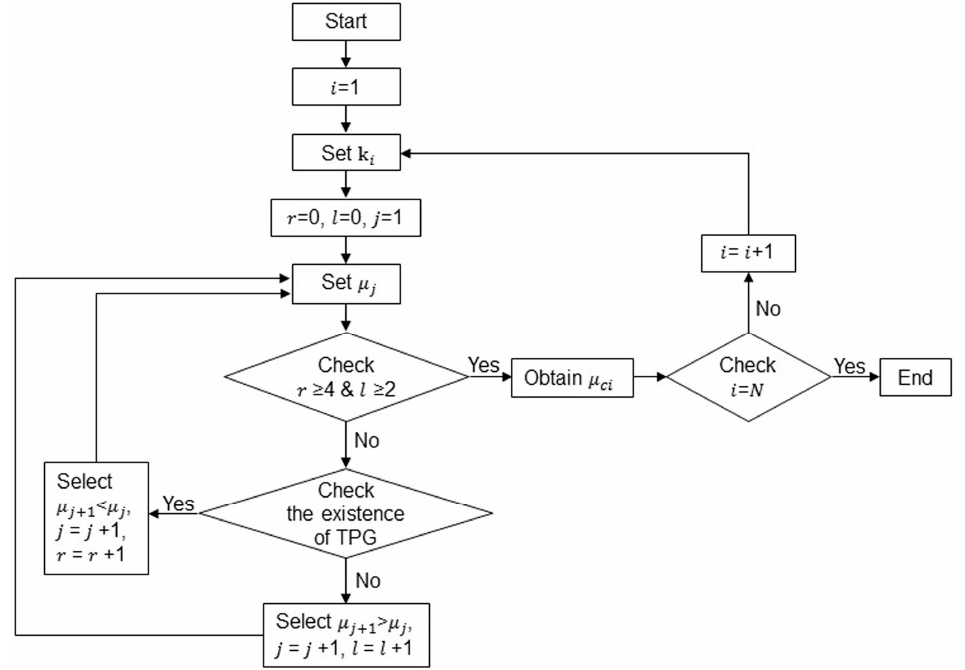
Figure 3. The experimental flow diagram of critical viscosity for the existence of the TPG at a given permeability.